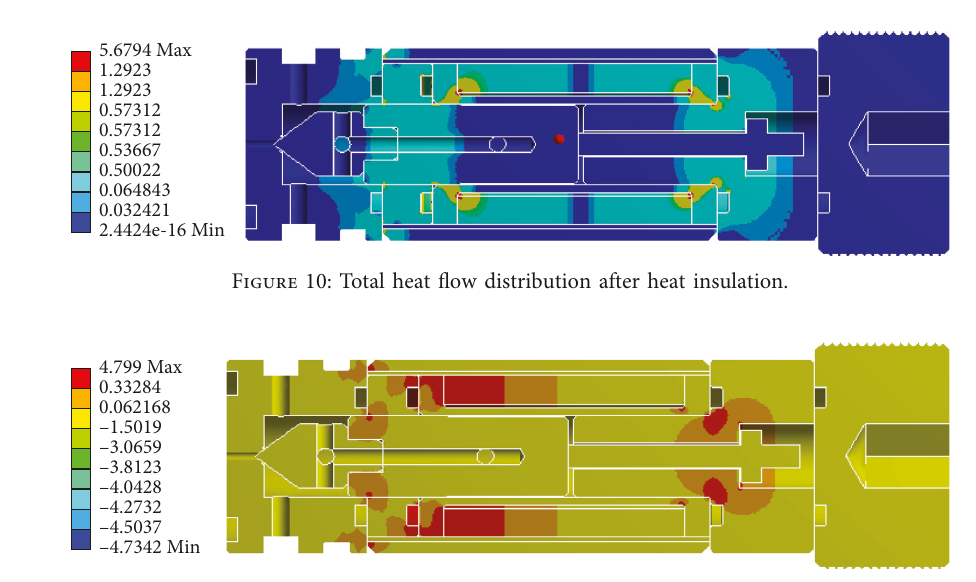
Figure 11: X -direction heat flow distribution after heat